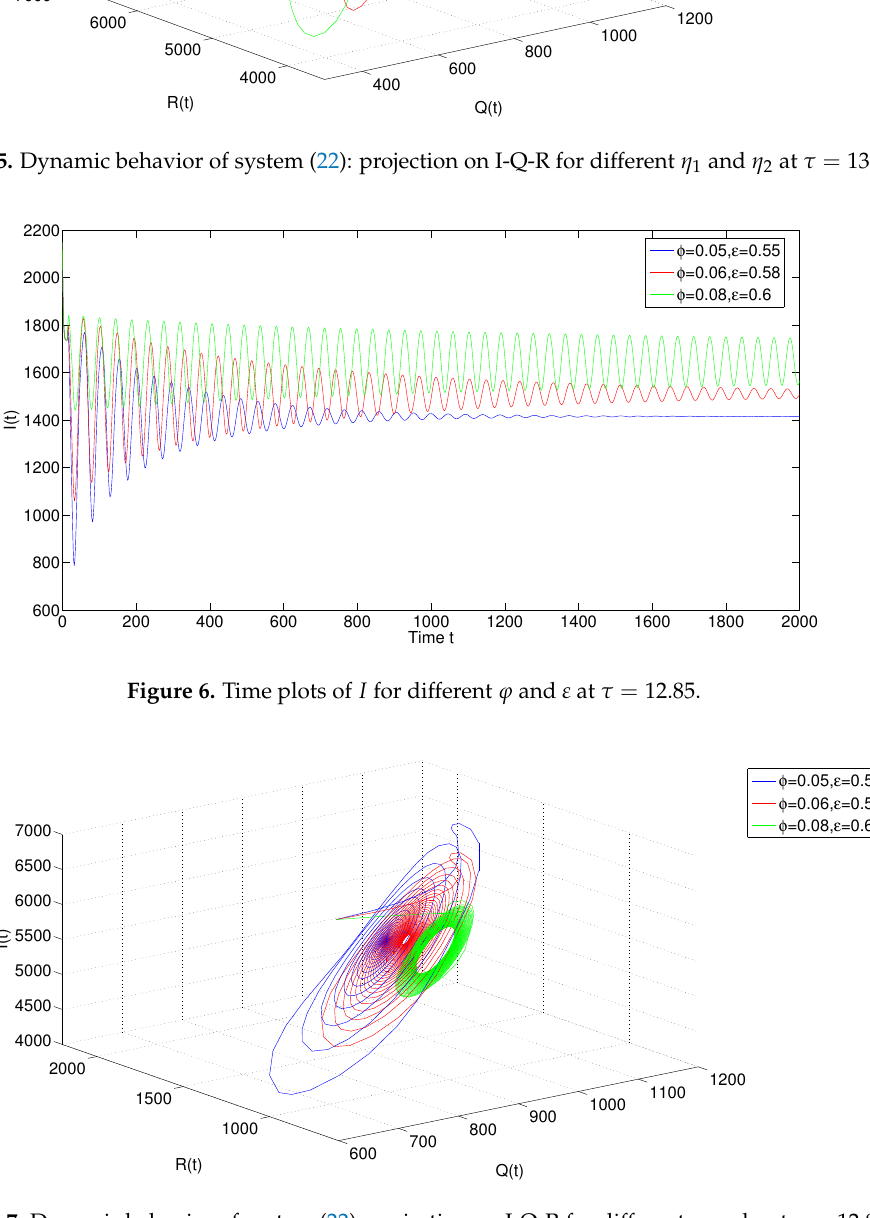
Figure 7. Dynamic behavior of system (22): projection on I-Q-R for different ϕ and ε at τ =